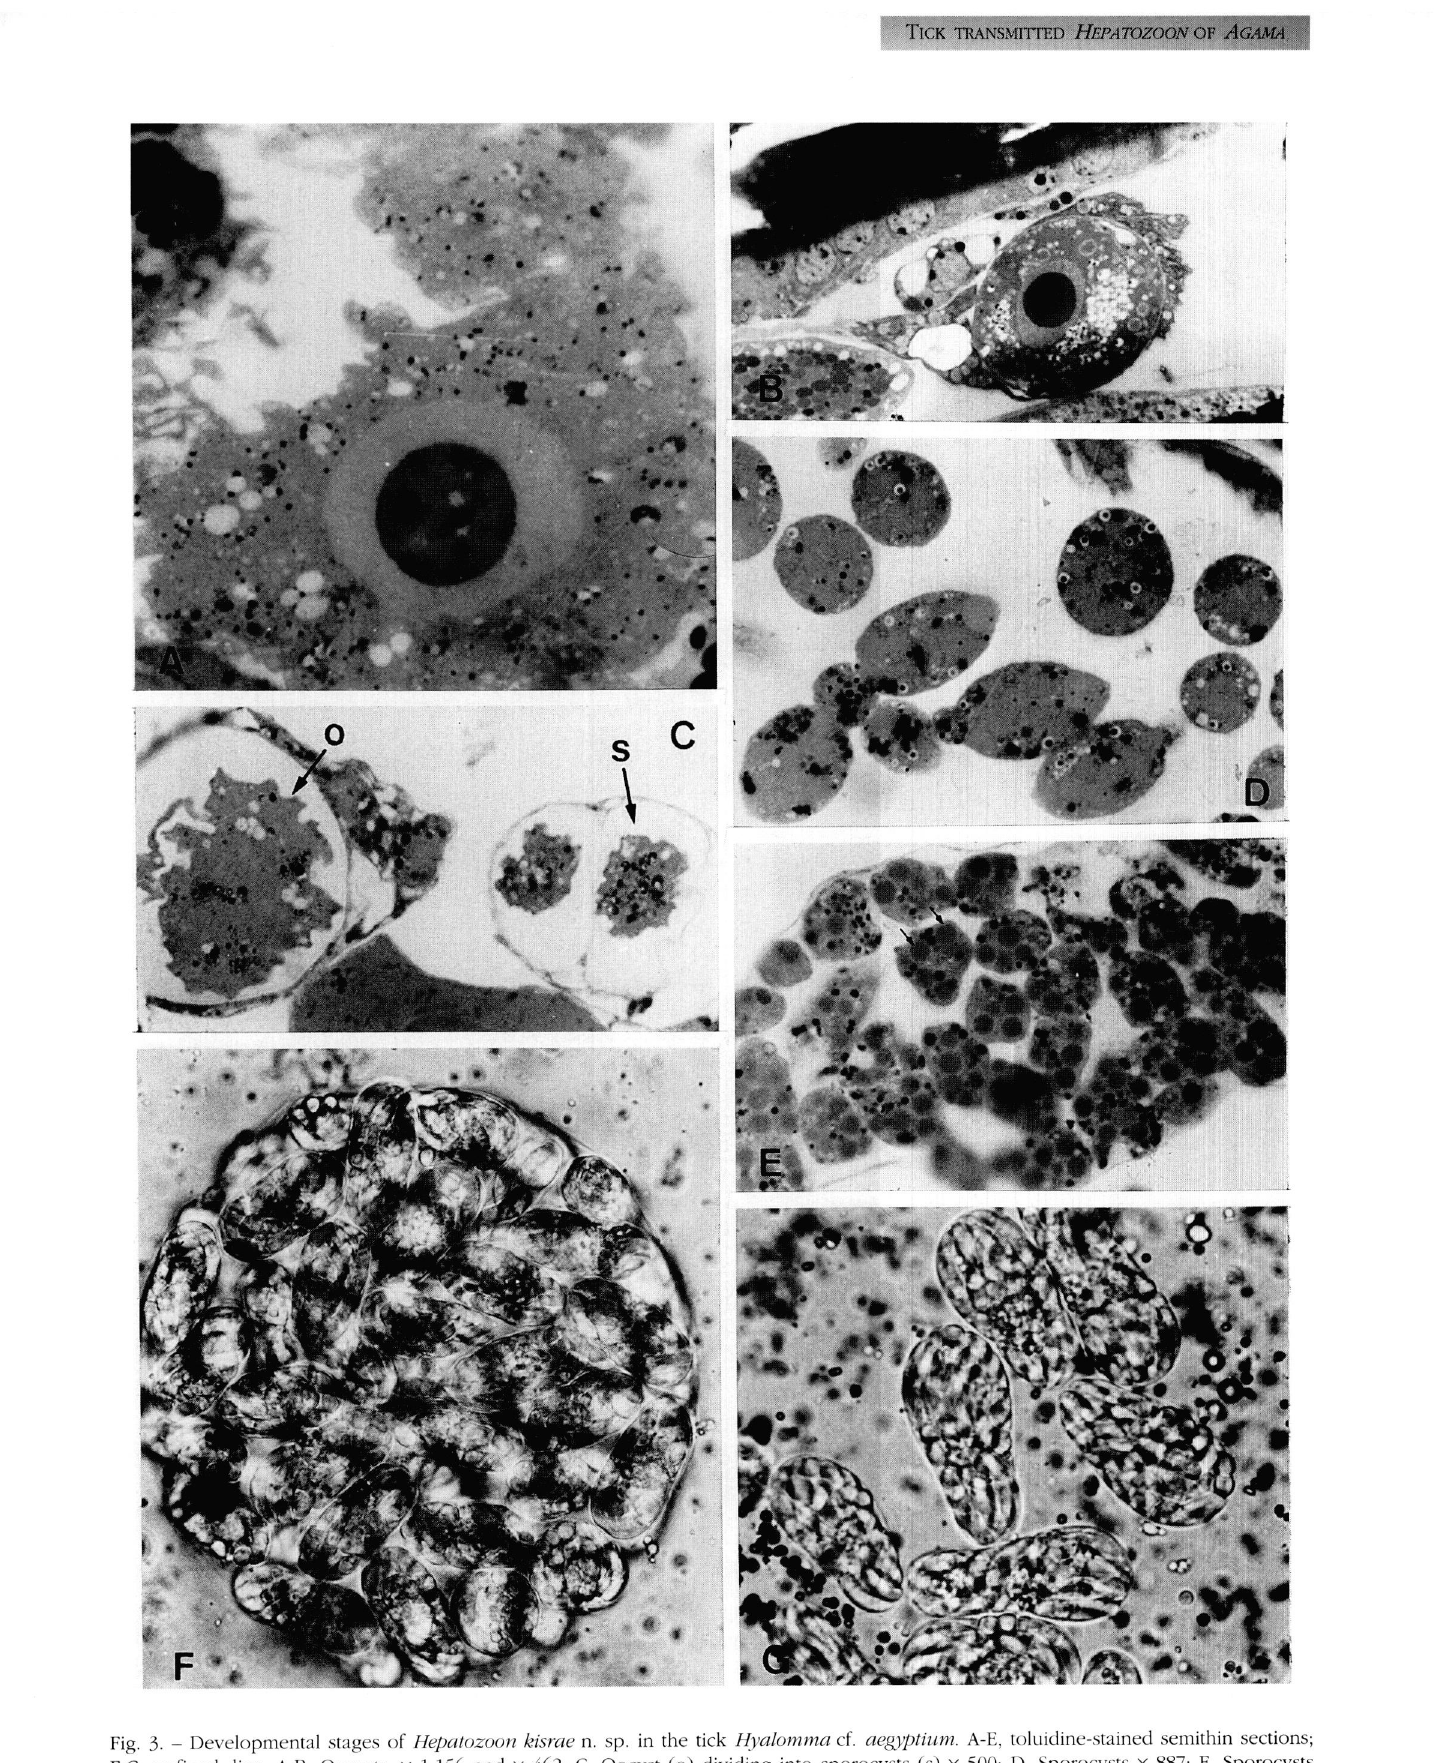
Parasite, 2002, 9, 17-27 23